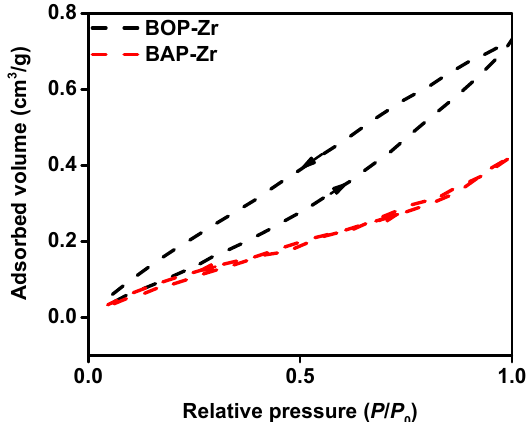
Figure 1. N 2 adsorption-desorption isotherms of the bioadsorbents BOP-Zr (black-dashed line) and BAP-Zr (red-dashed line).